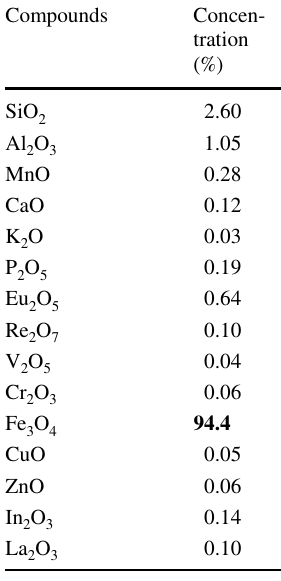
94.4% is the percentage of iron oxide in the synthesized